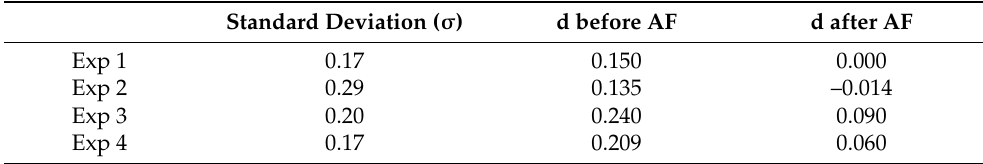
Table 1. Standard deviation ( σ ) and mean of the differences (d) before and after conversion for Exp1, Exp2, Exp3, and Exp4. Standard Deviation ( σ ) d before AF d after AF Exp 1 0.17